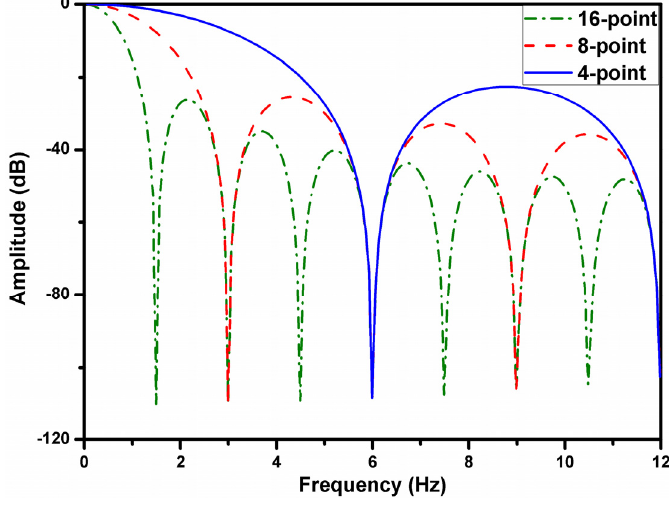
Figure 8. Simulated frequency response of the adjustable cascade moving average filter.